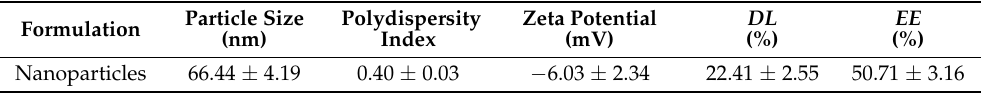
Table 1. Particle characteristics, drug entrapment, and loading of developed nanoparticle formulation. Particle Size Formulation (nm)